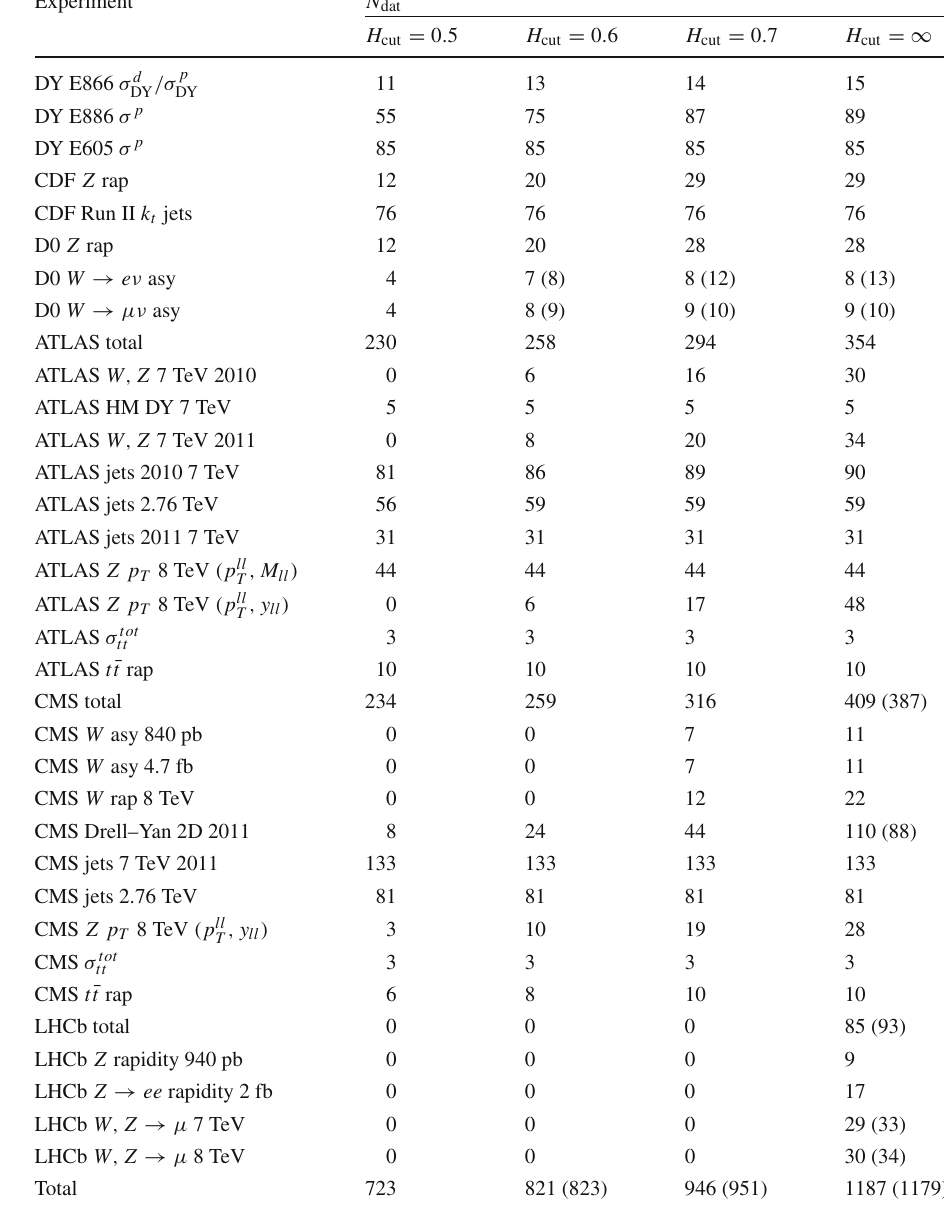
Table 2 The number of data points N dat for each of the hadronic experiments included in the NNLO NNPDF3.1sx global fits for different values of H cut = 0 . 5 , 0 . 6 and 0.7, with the default value being H cut = 0 . 6. The number in brackets corresponds to the values for the NLO fits, if different from the NNLO value. For completeness, we also show N dat when the H cut is not applied ( H cut = ∞ ). The last row indicates the total number of hadronic data points included in the fit for each